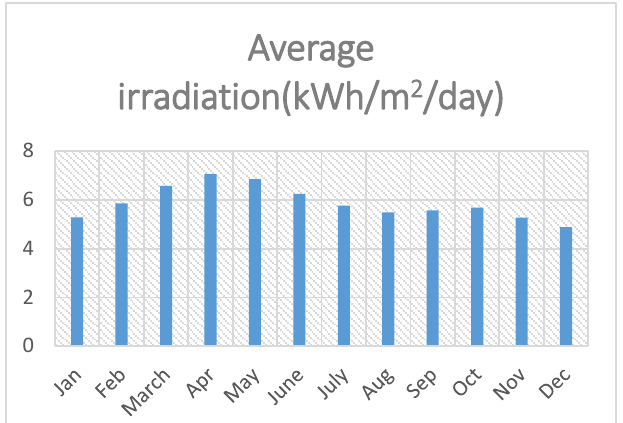
Figure 1. Annual variation of monthly average irradiation of Ngoundiane Site